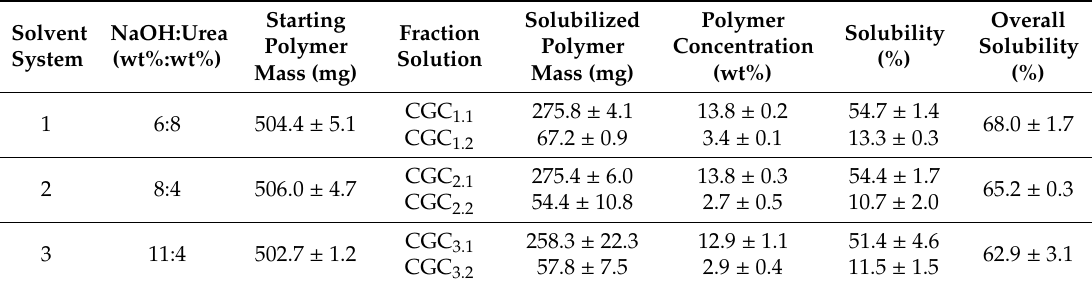
Table 1. Solubilized CGC mass, polymer concentration and overall solubilization of the soluble fractions in di ff erent NaOH / urea solvent